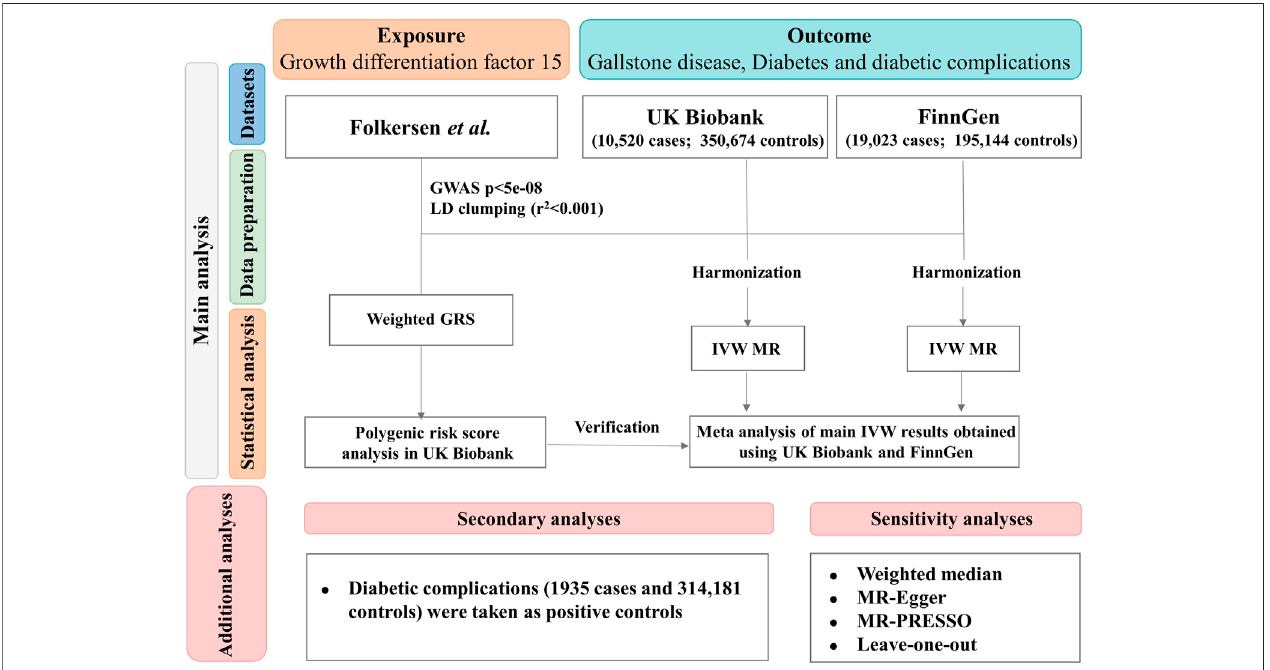
FIGURE 1 | Schematic representation of the study design. MR, Mendelian randomization; IVW, inverse variance weighted; GRS, weighted genetic risk score; LD, linkage disequilibrium; GWAS, genome-wide association study.